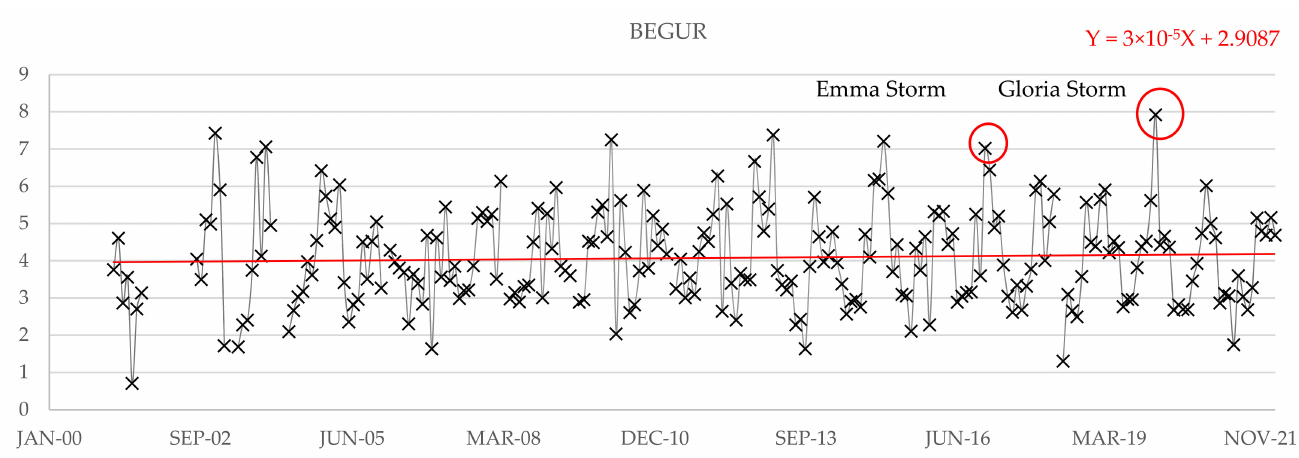
Figure 9. Evolution of Hs maxima in Tarragona.